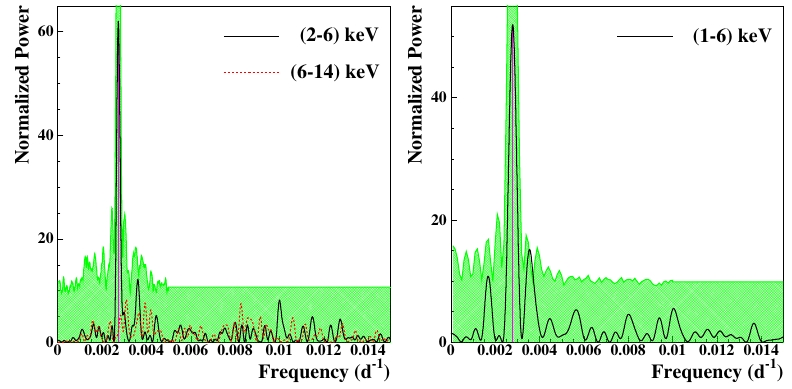
Figure 3. Power spectra of the time sequence of the measured single-hit events for DAMA/LIBRA– phase1 and DAMA/LIBRA–phase2 grouped in one day bins around the 1 y − 1 peak, for (2–6) keV (solid line) and (6–14) keV (dotted line) energy intervals (left panel) and for only DAMA/LIBRA–phase2 in the (1–6) keV energy interval (right panel). The main mode present at the lowest energy interval corresponds to a frequency of 2.74 × 10 − 3 day − 1 (left panel) and 2.79 × 10 − 3 day − 1 (right panel), vertical line, purple online. It corresponds to a period of (cid:39) 1 year. A similar peak is not present in the (6–14) keV energy interval. The shaded (green online) area in the bottom figure—calculated by Monte Carlo procedure—represents the 90% C.L. region where all the peaks are expected to fall for the (2–6) keV and (1–6) keV energy intervals. In the frequency range far from the signal for the (2–6) keV and (1–6) keV energy regions and for the whole (6–14) keV spectrum, the upper limit of the shaded region (90% C.L.) can be calculated to be 10.6 (continuous lines, green